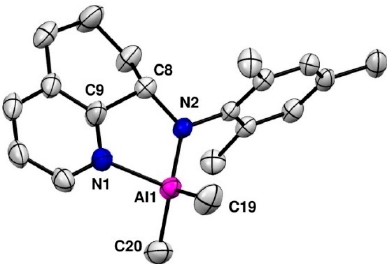
Figure 1. ORTEP of the molecular structure of Al4 . Ellipsoids at 50% probability level. Hydrogen atoms are omitted for clarity. Selected distances (Å) and angles (deg): A1–N1 1.981(3), A1–N2 1.844(2), A1–C19